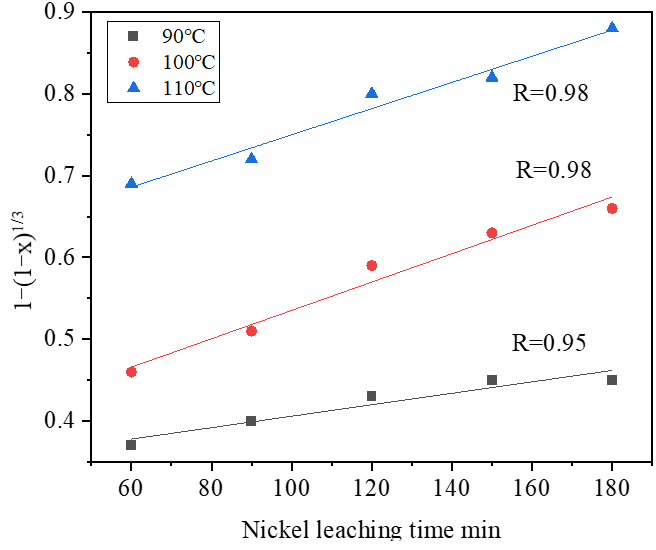
Separations 2023 , 10 , x FOR PEER REVIEW Figure 9. Kinetic curves of Ni leaching at different temperatures. Figure 9. Kinetic curves of Ni leaching at different temperatures.